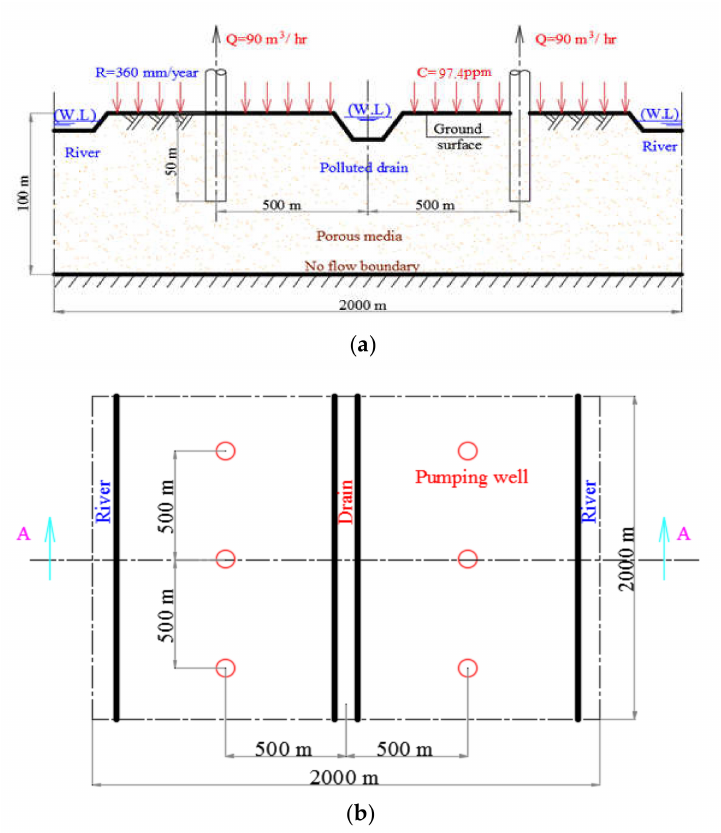
Figure 1. Cross section and plan of the study area ( a ) section elevation A-A and ( b )